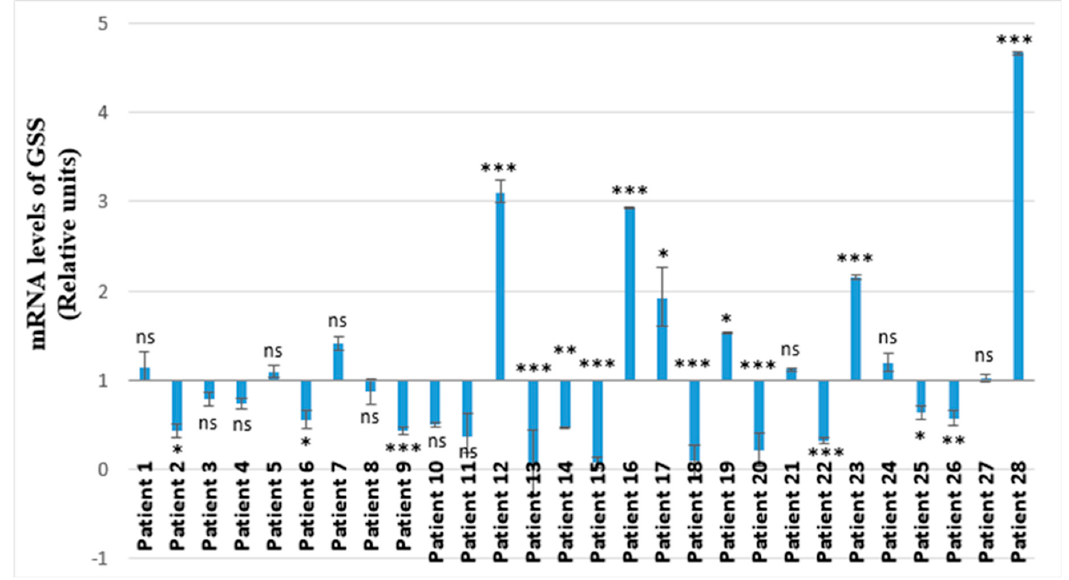
Figure 3. GSS mRNA levels in saliva of 28 children with diagnosed pyelonephritis. Expression levels are presented in relative units ± SEM versus human β -actin as endogenous control. * p < 0.05 versus control group; ** p < 0.01 versus control group; *** p < 0.001 versus control group; ns—not significant.